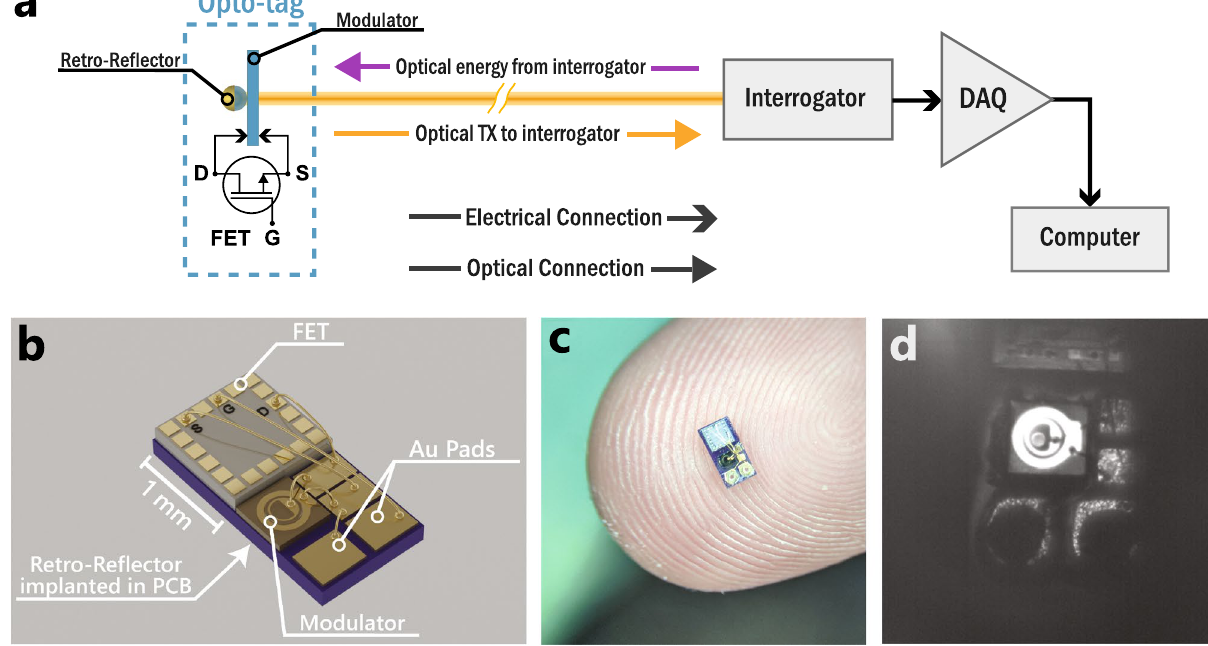
Figure 1. ( a ) Schematic of free space optical link test system showing the opto-tag comprised of a FET, SQWM, and a retro-reflector and the optical/electrical connections between the tag and the interrogation system. ( b ) 3D render showcasing the design of the SWIR opto-tag. ( c ) Stereo-Microscope image of the final device used in this work. ( d ) SWIR image of the mounted modulator showing the retro-reflector embedded